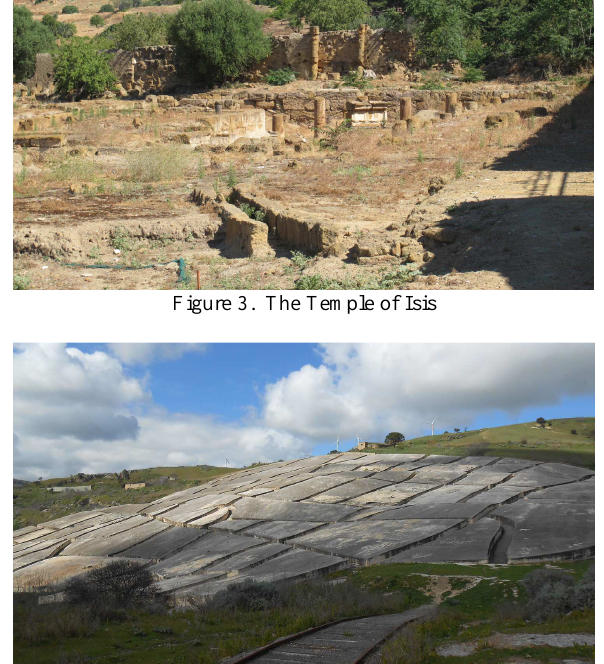
Figure 4. The "Cretto of Gibellina"